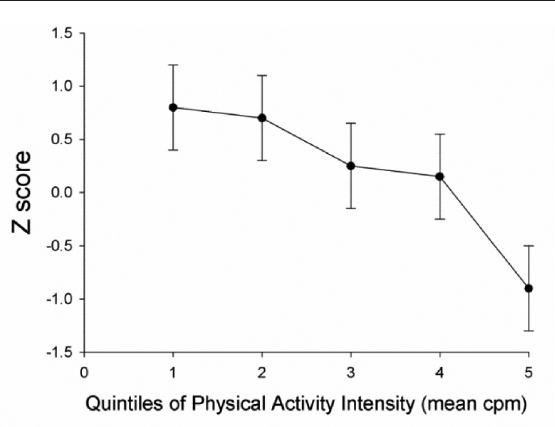
Figure 2. Mean Z score in the quintiles of average physical activity intensity. Vertical bars = 95% CI. Adapted from (Andersen et al., 2006: License permission 3153560906548; Content publisher: Elsevier; Content publication: The